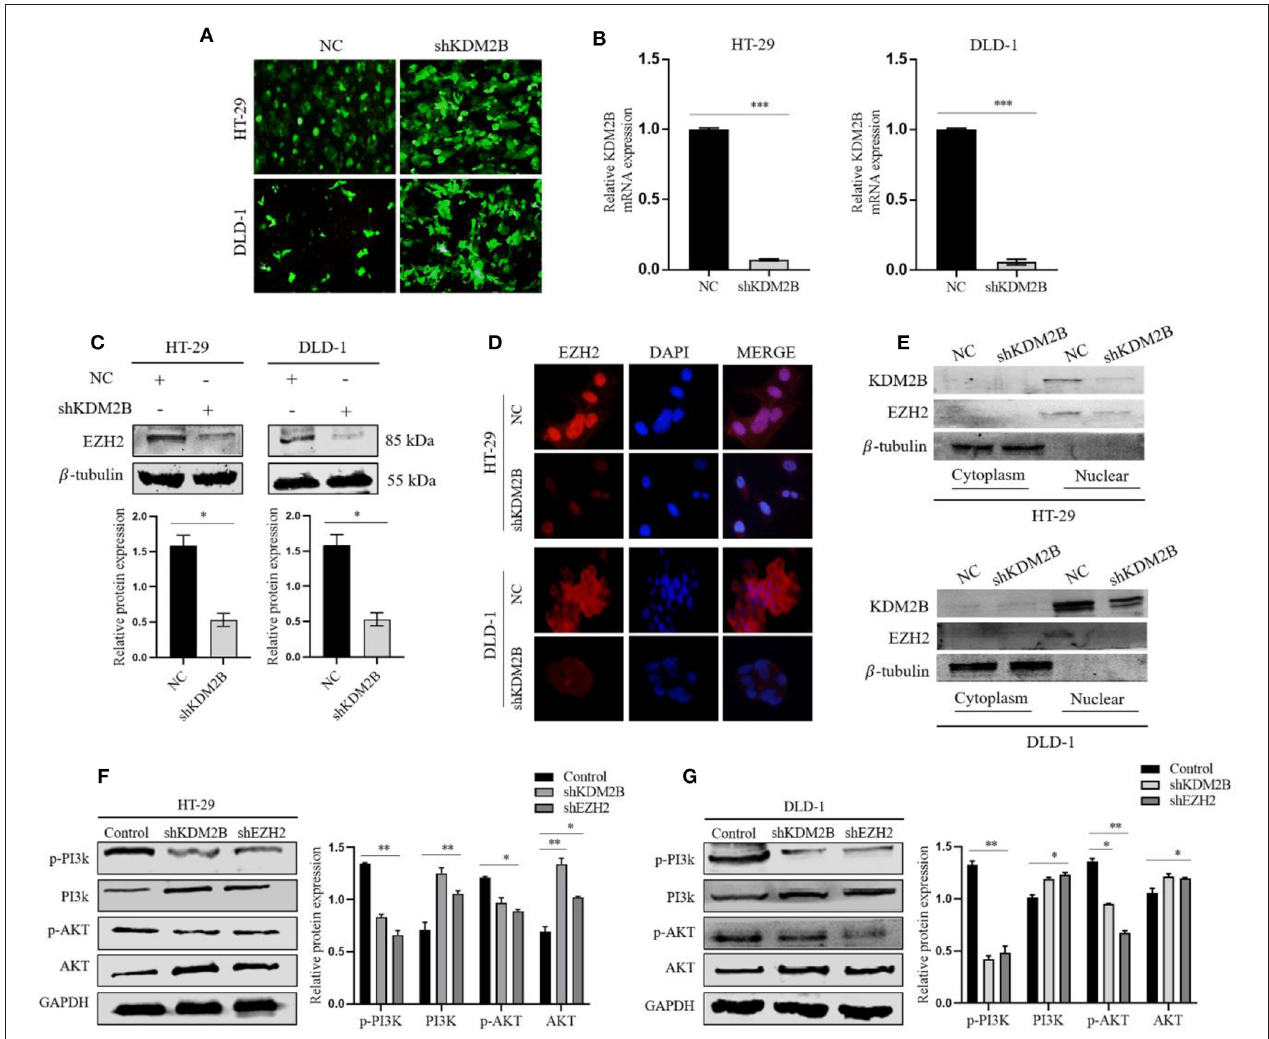
FIGURE 4 | KDM2B suppresses the expression of EZH2 in CRC and activates the PI3K/AKT signaling pathway. (A) HT-29 and DLD-1 cells were infected with shRNA against KDM2B (shKDM2B) and negative control (NC), and more than 90% of cells had green fluorescence under the fluorescence microscope. Representative microscopic pictures were taken. (B) The relative expression of KDM2B mRNA was examined by real-time qRT-PCR after normalizing to GAPDH ( n = 3), *** p < 0.001. The expression of EZH2 protein was determined by Western blotting and immunofluorescence after transfecting KDM2B as described in (A,C,D) . (C) Shows Western blot result and representative quantification of EZH2 expression in HT-29 and DLD-1. β -tubulin was used as a loading control. (D) Immunofluorescence was performed using FITC-labeled phalloidin. The cells were stained with anti-KDM2B and anti-EZH2 antibodies (red) and DAPI (blue) and observed under a fluorescence microscope (Scale bar: 20 µ m, magnification, 40 × ). (E) The cytosolic and nuclear proteins were extracted from HT-29 and DLD-1 transfected cells with shKDM2B or control vectors (NC) and the protein levels of KDM2B and EZH2 were measured using Western blot analysis. β -tubulin was used as an internal control. (F,G) The downregulation of KDM2B and EZH2 activated the PI3K/AKT signaling pathway. The expression levels of PI3K/AKT pathway target genes, including p-PI3K, PI3K, p-AKT, and AKT, were analyzed by Western blot Assay. GAPDH was used as a loading control. The data was statistically significant at * p < 0.05, ** p < 0.01, *** p